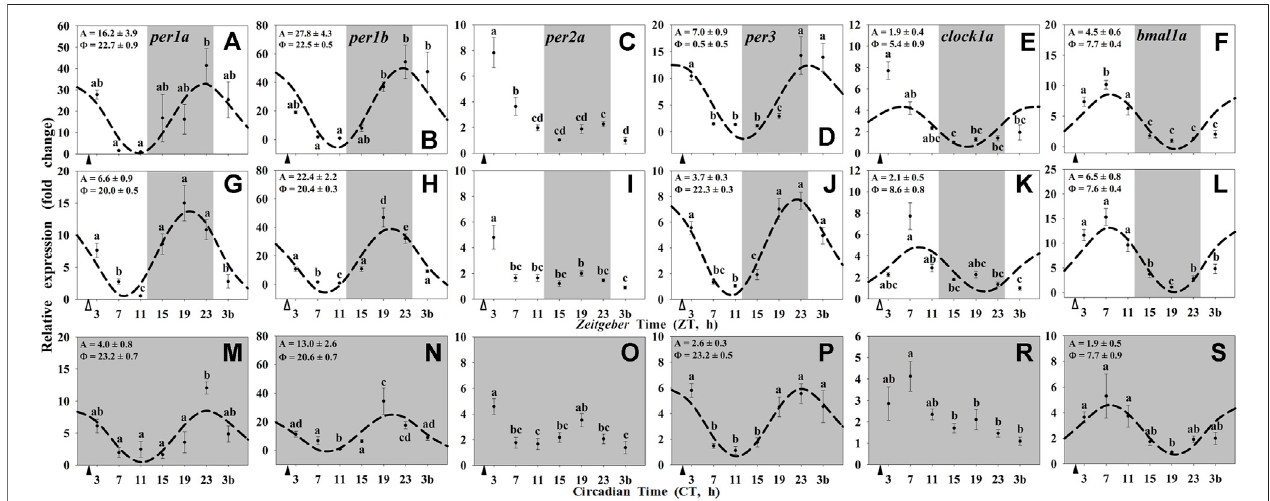
FIGURE2| Dailypro fi leofclockgenestranscriptsintheliverofgold fi shmaintainedunderdifferentlightingconditionsandfeedingprotocols.Greyareaindicatesthe dark period. Feeding time is indicated by triangles in the x-axis (solid, ▲ , scheduled feeding at ZT/CT 2; white, Δ , random feeding with the last meal at ZT 2). Data are shown as mean ± SEM ( n = 5 – 7) in relative units (2 − ΔΔ Ct method). Different letters indicate signi fi cant differences (ANOVA p < 0.05, SNK post hoc test). When Cosinor ( SE(A)/A < 0.3 ) was signi fi cant and A > 1 , periodic sinusoidal functions were represented as dashed curves with the corresponding amplitudes and acrophases ( A and Φ ,